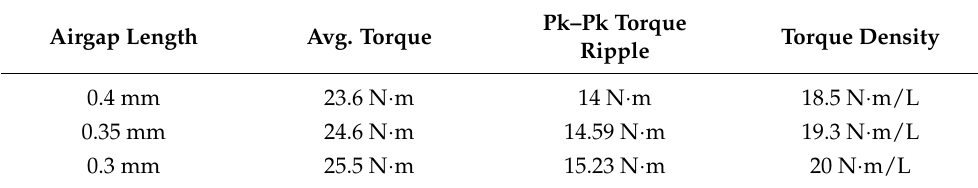
Table 3. Average torque and torque ripple of the torque profiles in Figure